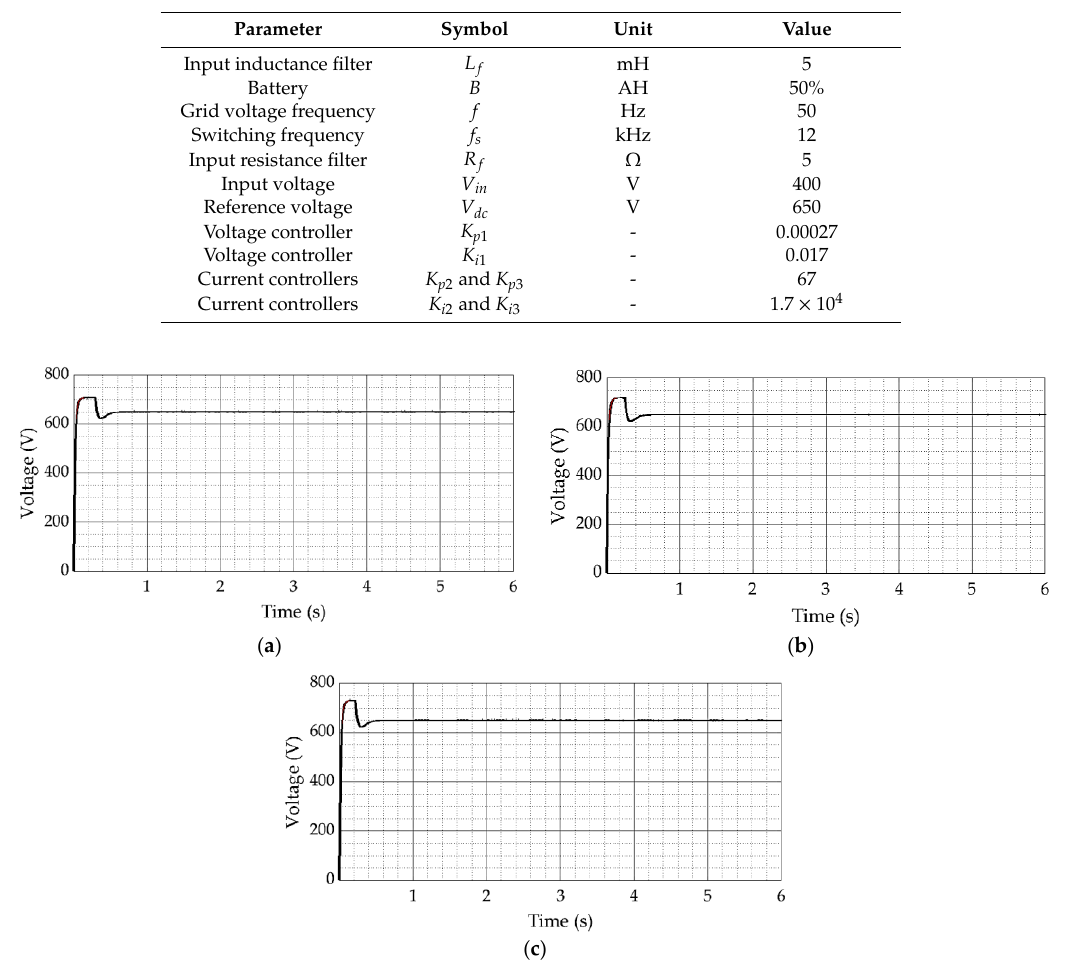
Figure 11. The input current waveform for Level 2 charging (Phase A).